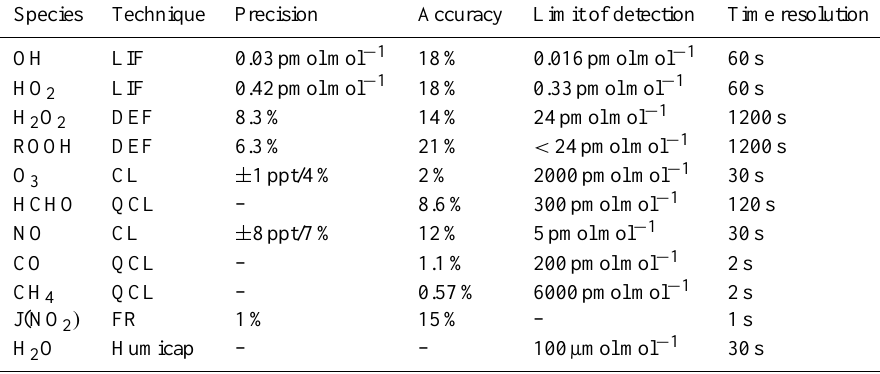
Table 3. Techniques employed to measure trace species during HOOVER. Abbreviations are explained in the corresponding text.